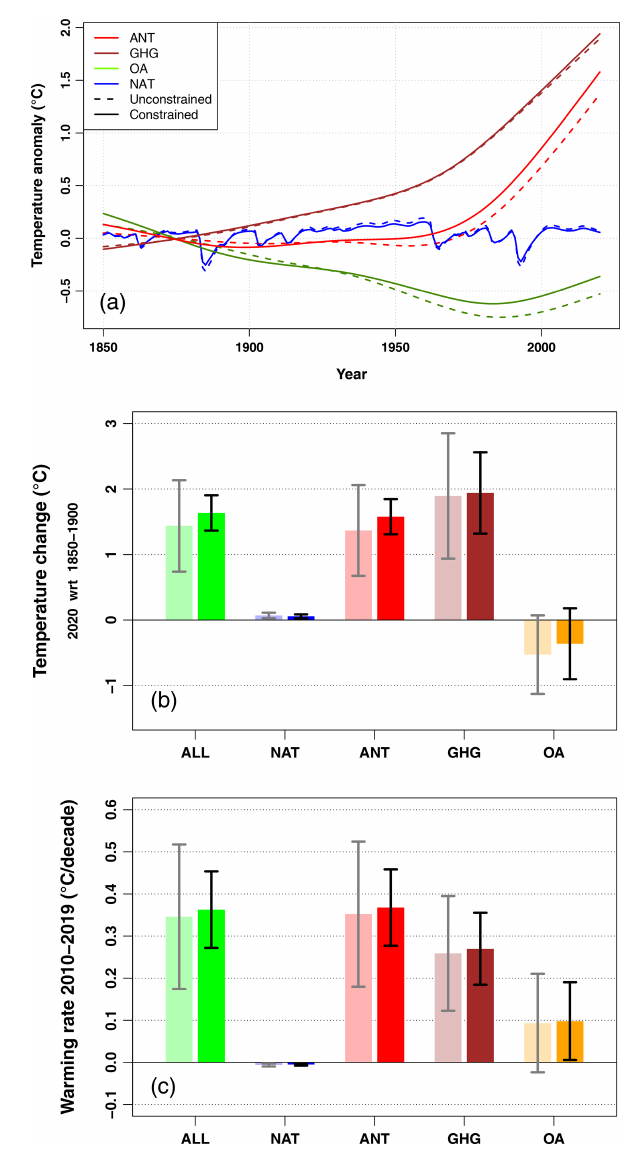
Figure 3. Attribution of warming to date and warming rate. (a) Constrained and unconstrained time series of the response to nat- ural (NAT), greenhouse gas (GHG), other anthropogenic (OA), and anthropogenic (ANT = GHG + OA) forcings over the period 1850– 2020. (b) Temperature change induced by various subsets of ex- ternal forcings over the historical period (estimated in 2020 with respect to 1850–1900). For each subset of forcings, the left-hand bar and gray confidence interval describe the unconstrained CMIP6 model range, assuming a Gaussian distribution. The right-hand bar and black confidence interval correspond to results constrained by global and local observations. All ranges shown are 595% to 95% confidence ranges. The SSP2-4.5 scenario is used to extend histori- cal simulations after 2014. (c) The same analysis for the 2010–2019 warming rate computed as a linear trend over that period and ex- pressed in degrees Celsius by decade.